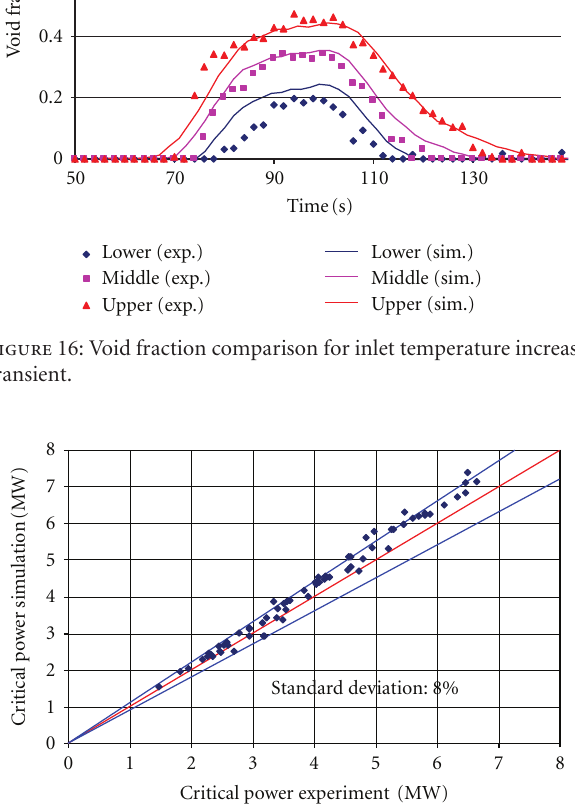
Figure 17: Measured and simulated critical power values for assem- bly A0.